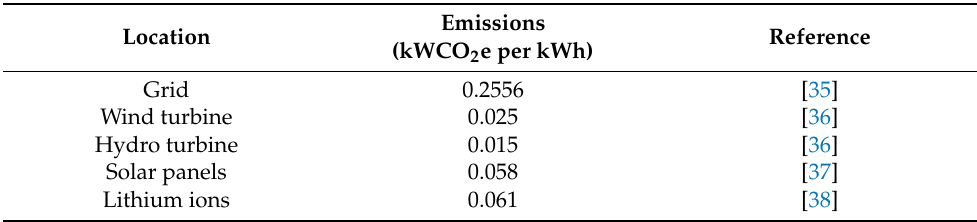
Table 2. Emissions of production associated with